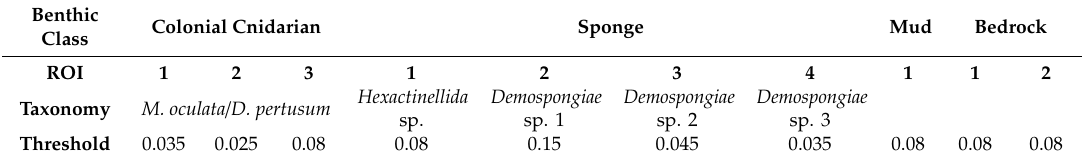
Table 1. Selected ROIs for the benthic classes of the CWC site and relative threshold values used in the ‘Rule classifier’ tool.